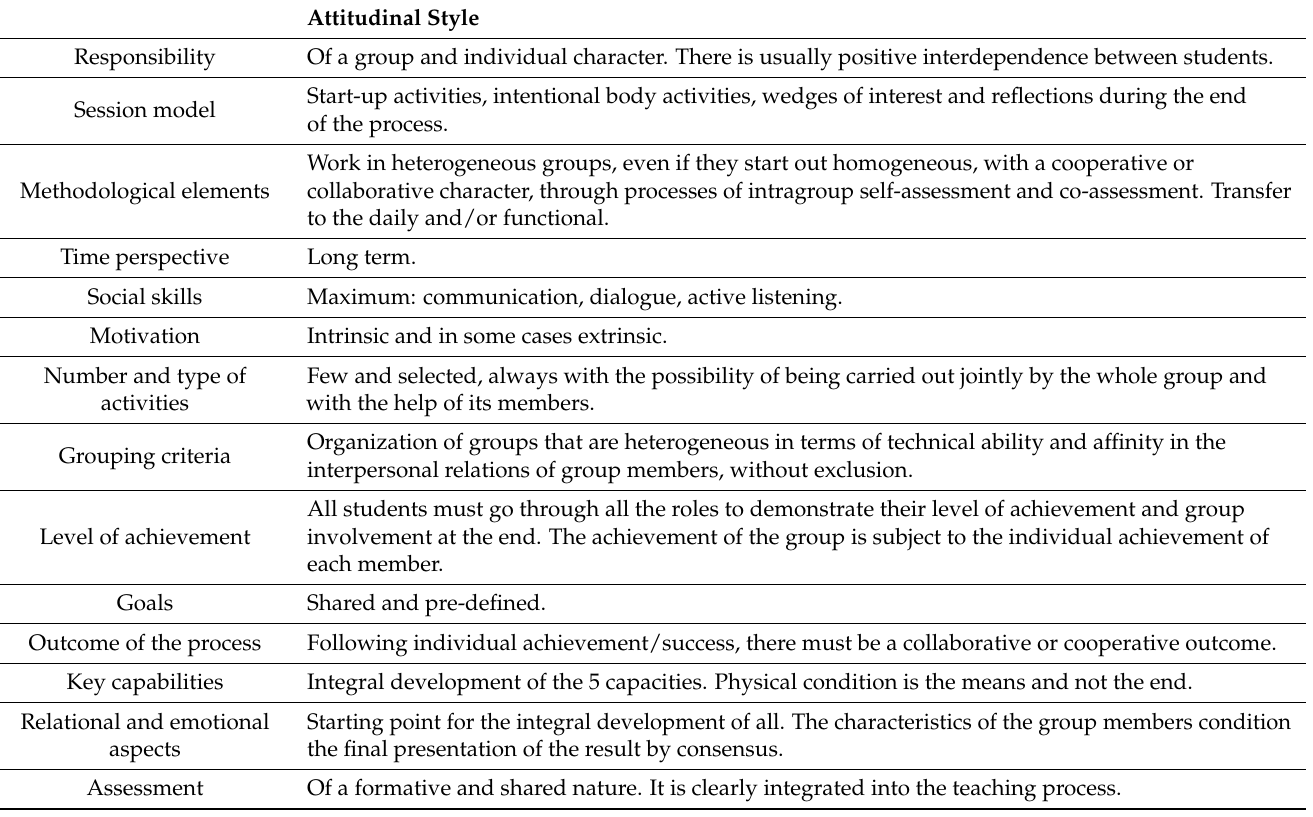
Table 1. Fundamental elements of the Attitudinal